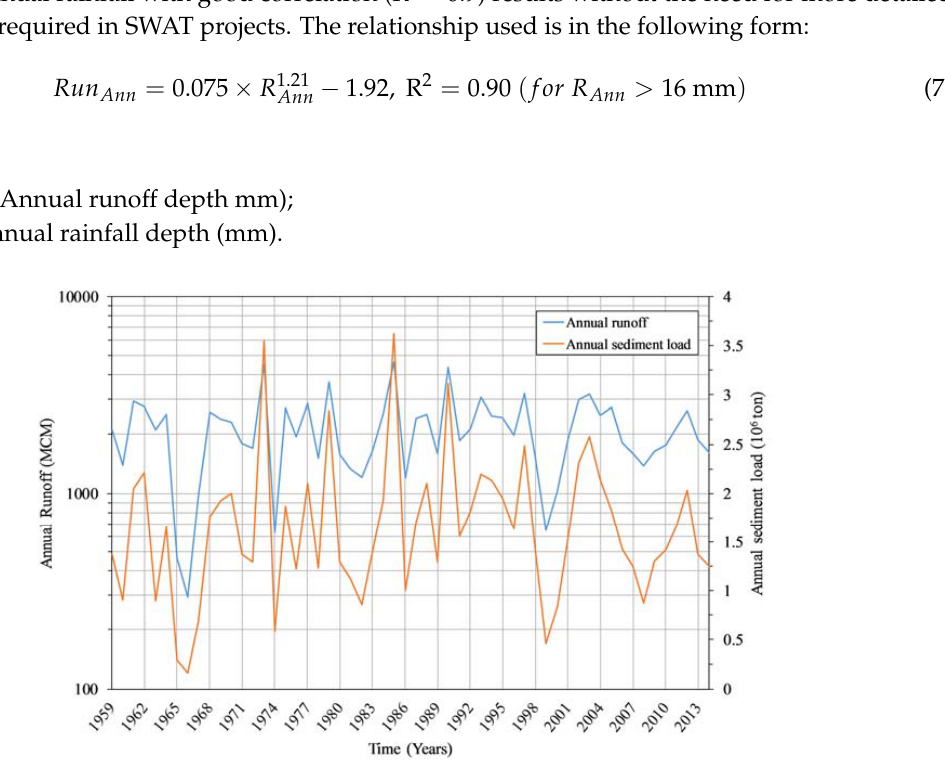
Figure 7. Annual runoff volume and sediment load delivered to the Dokan Reservoir for the period